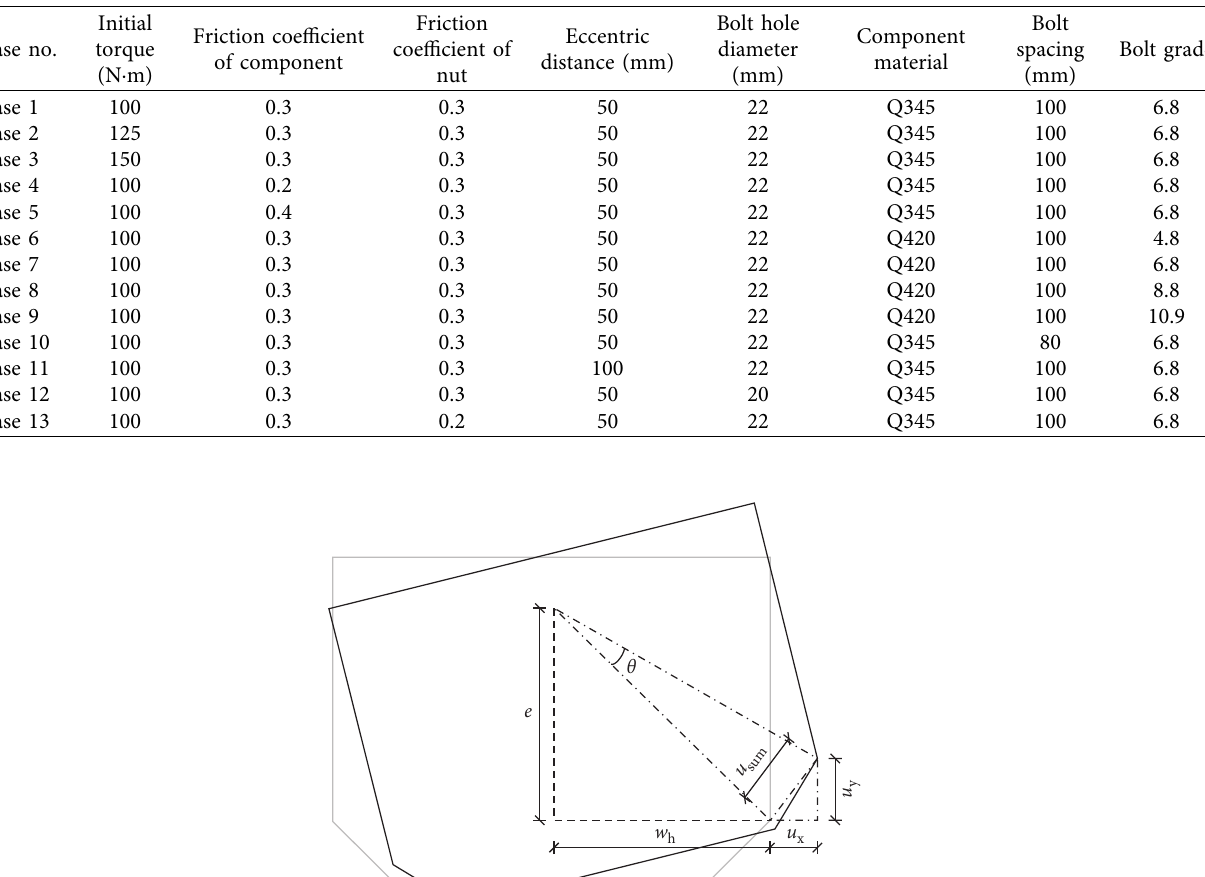
Figure 2: Constitutive relation. Table 1: Numerical scheme.